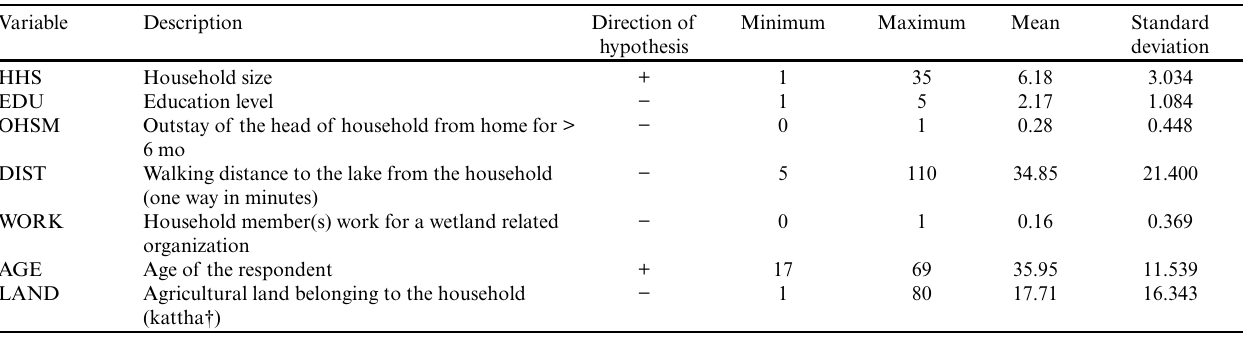
Table 2. Explanatory variables, associated hypothesis for direction of the relation with lake resource use, and descriptive statistics.